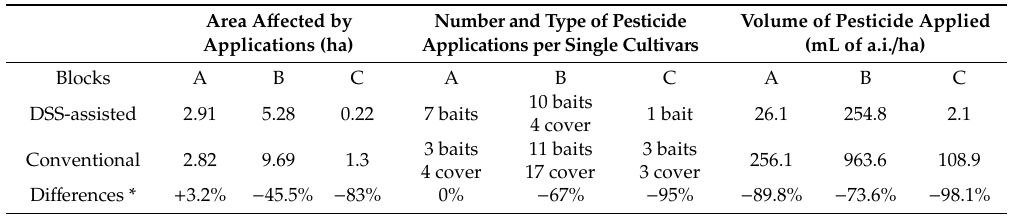
Table 2. Main indicators calculated to evaluate the e ff ectiveness of the DSS-assisted management compared to the conventional one, with the di ff erences reported in percentages. Area A ff ected by Number and Type of Pesticide Volume of Pesticide Applied Applications (ha) Applications per Single Cultivars (mL of a.i. / ha)